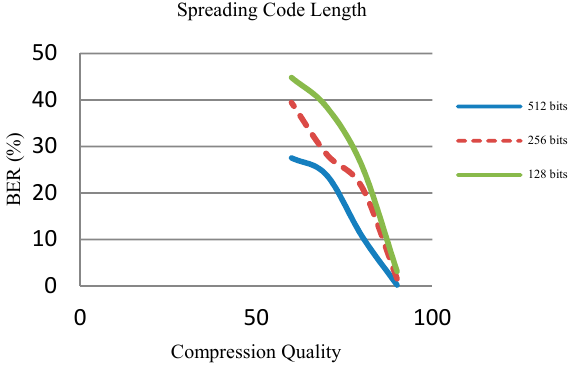
Figure 6. Compression Quality Vs BER in the case of different spreading code length. Table 3. Extracted watermark after different attacks in the case of different spread code length.